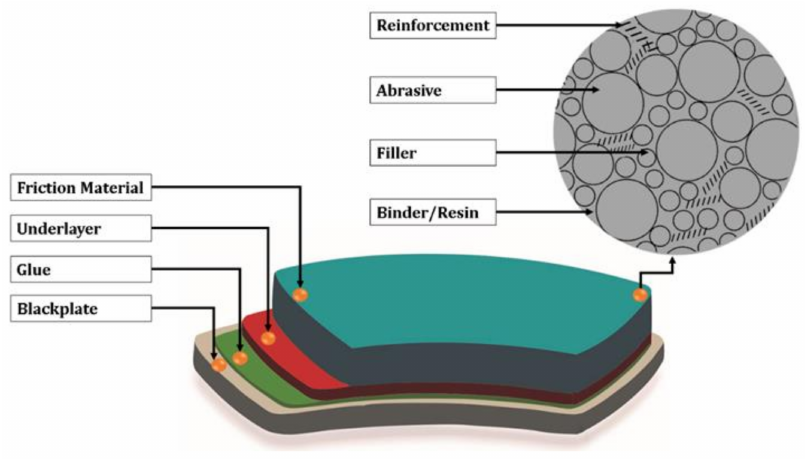
Figure 3. The layers of the brake